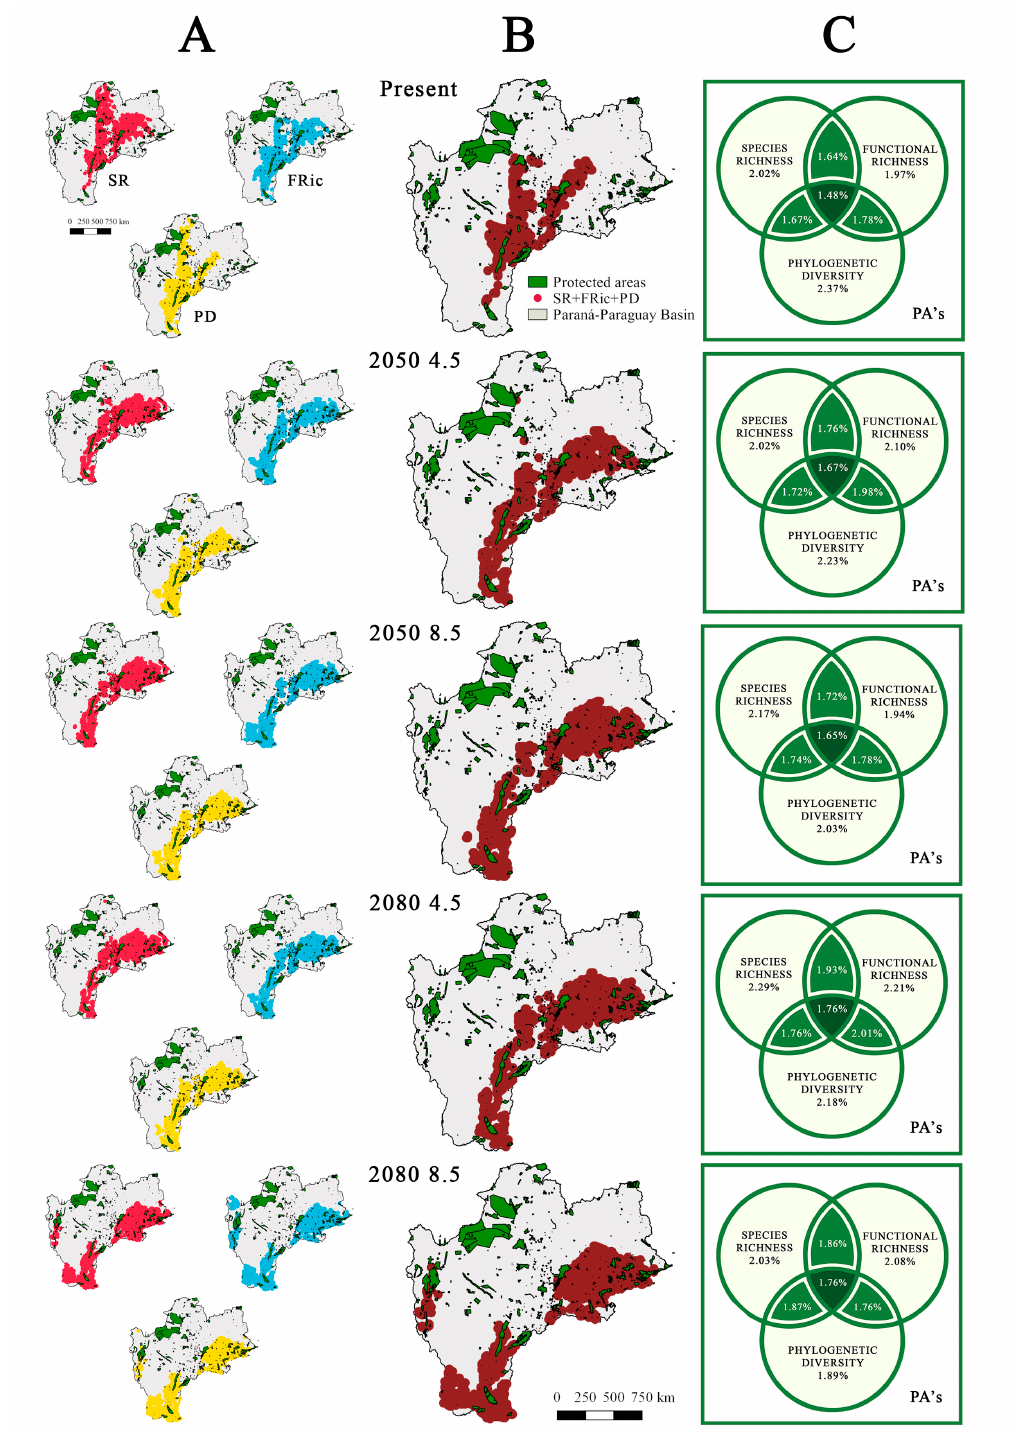
FIGURE 2 | Paraná-Paraguay basin and the 17% of the area with the highest values of species richness (SR), functional richness (FRic), and phylogenetic diversity (PD), as well as the protected areas (PAs). A. SR, FRic, and PD, as well as their individual distribution for the current and future scenarios of climate change; B. the overlap between SR, FRic, and PD, as well as the protected areas in the Paraná-Paraguay basin, for the current and future scenarios of climate change C. The Venn diagrams showing the percentage of overlap between the components of fish diversity and the protected areas currently in the